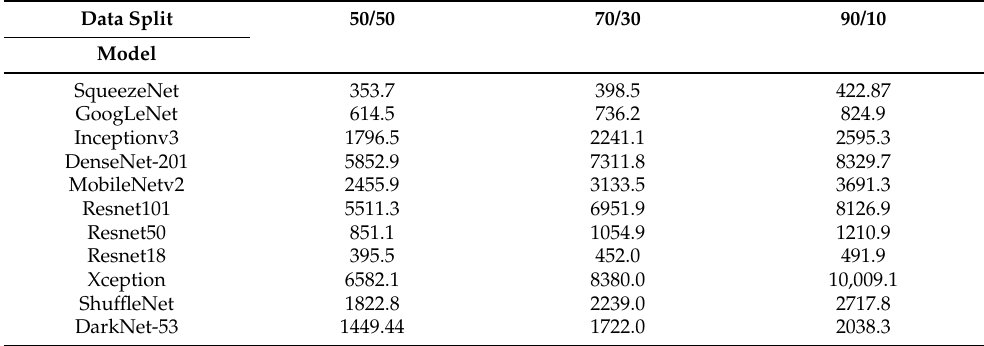
Figure 8. The mean, minimum, and maximum accuracy for all algorithms over 10 randomized runs and 90/10 data split. Table 4. The mean training and validation times for all algorithms and data split strategies. All times are in